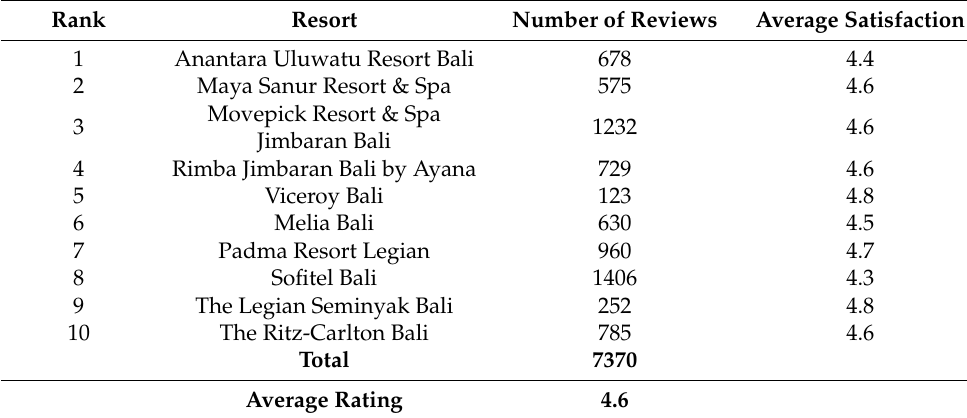
Table 1. Number of Review.